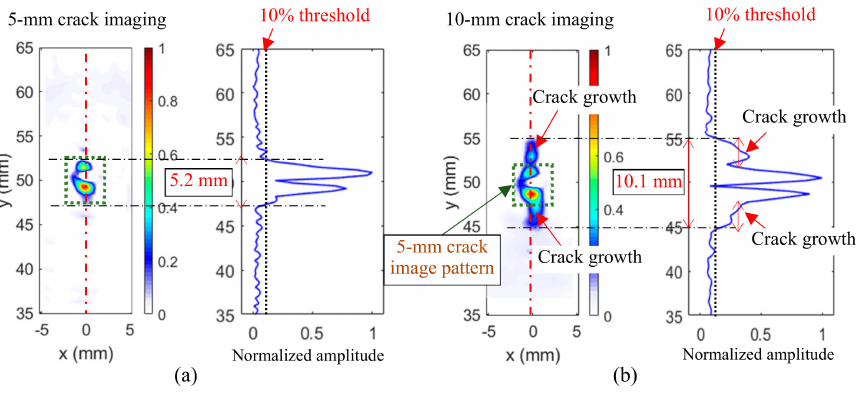
Figure 8. The cross-correlation imaging results: ( a ) 5-mm fatigue crack and ( b ) 10-mm fatigue crack.